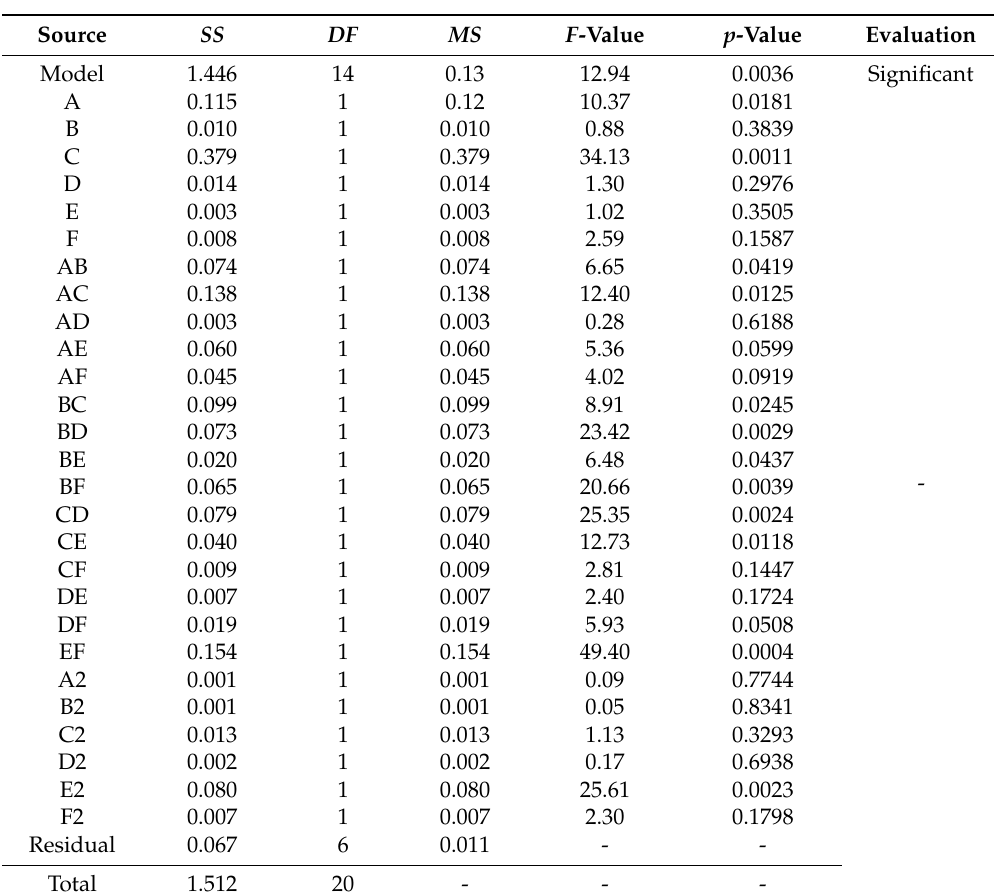
Table A7. ANOVA for quadratic model of weld